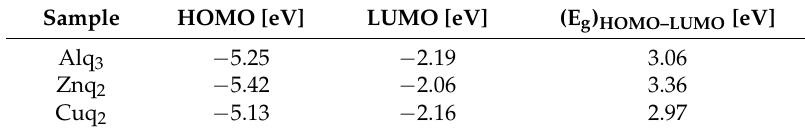
Figure 9. Theoretically simulated UV-Vis spectra of Alq 3 , Znq 2 , and Cuq 2 . Table 2. HOMO and LUMO energy levels and theoretical bandgap (E g ) HOMO–LUMO (B3LYP/6-31G(d)). Sample HOMO [eV] LUMO [eV] (E g ) HOMO–LUMO [eV] Alq